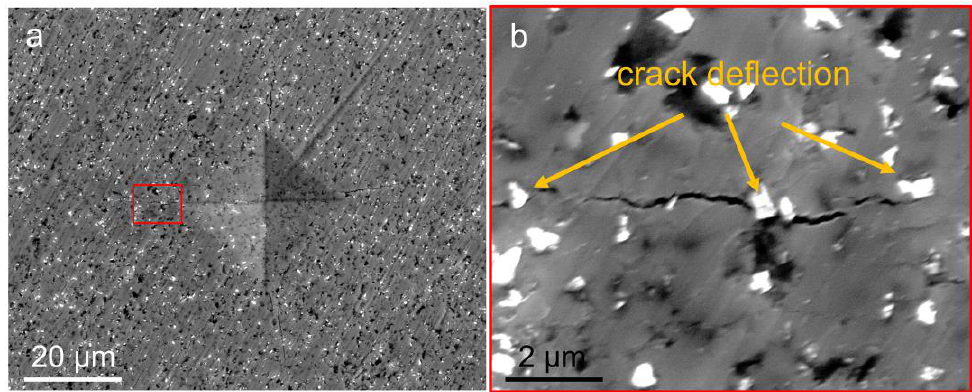
Figure 8. ( a ) SEM micrographs of the fracture surface of the T-10%D sample. ( b ) Magnified SEM image corresponding to the red-boxed area in ( a ).